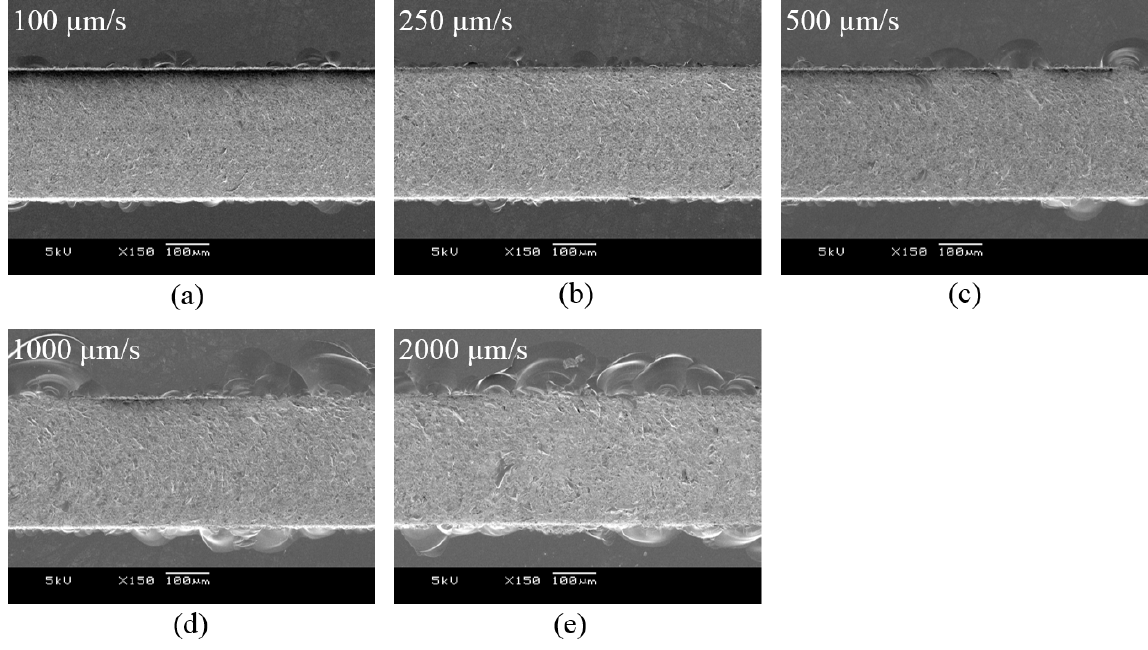
Figure 3. The cutting forces according to the different feed rates (feed rates: 10–2000 µm/s; depth of cut: 5 µm; 50,000 rpm).